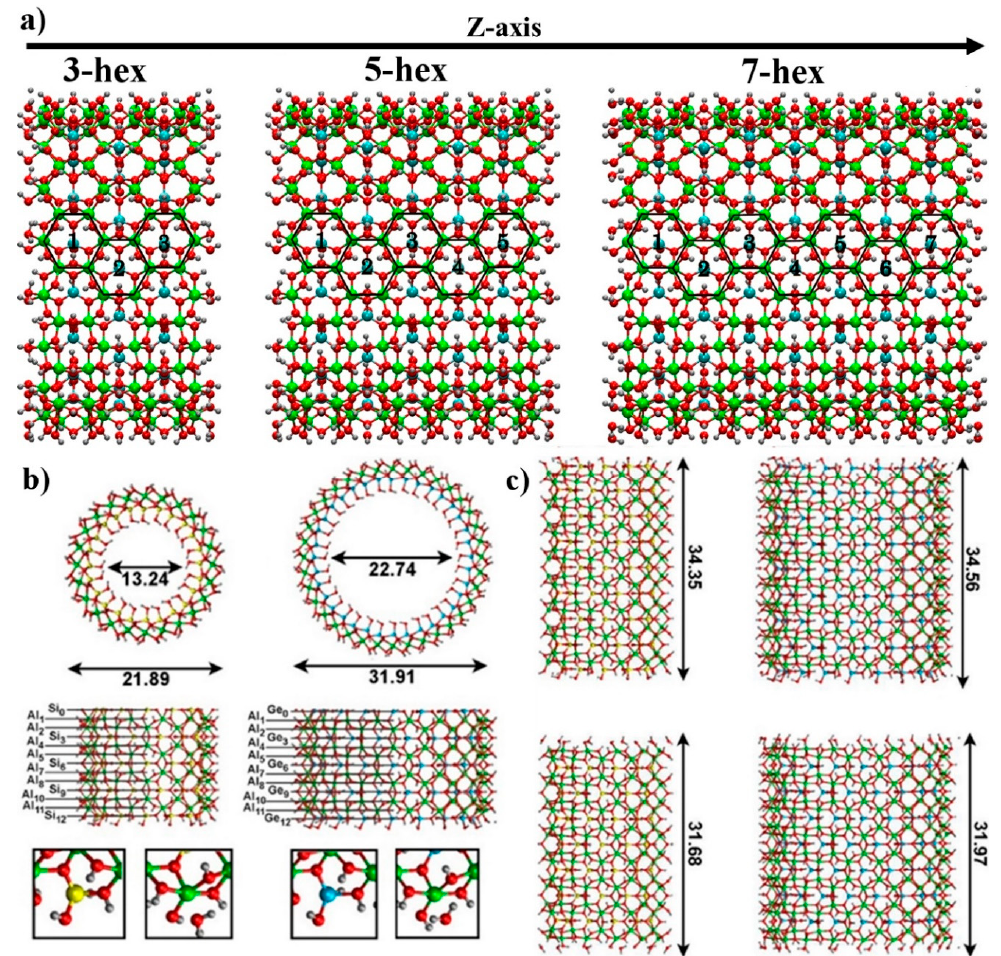
Figure 1. ( a ) Optimized geometry of the finite AlSi/AlGe NT models. The hex-3, 5 and 7 labeling reflects the number of complete Al hexagons along the (zigzag) NT axis. Al hexagons have been highlighted in black. ( b ) Front and side view of half of the optimized AlSi and AlGe finite models. The position of the tube-rings (R = 0–12) is marked by the black horizontal lines. R = 0 corresponds to the innermost Si(Ge) ring. The small squared panels contain a close up of the optimized atomic structure for the OH (left) and H 2 O (right) terminations of the AlSi and AlGe NT models. The optimized diameter of the finite NT models is reported in Å. ( c ) Side view of the full hex-7 models for the AlSi (left), and AlGe (right) NTs. The top and bottom rows reports the OH- and H 2 O-terminated models, respectively. The optimized length of the NT models is also marked in Å. The color labeling for the atoms is as follows: H (gray), O (red), C (brown), Al (green), Si (yellow), Ge (cyan).